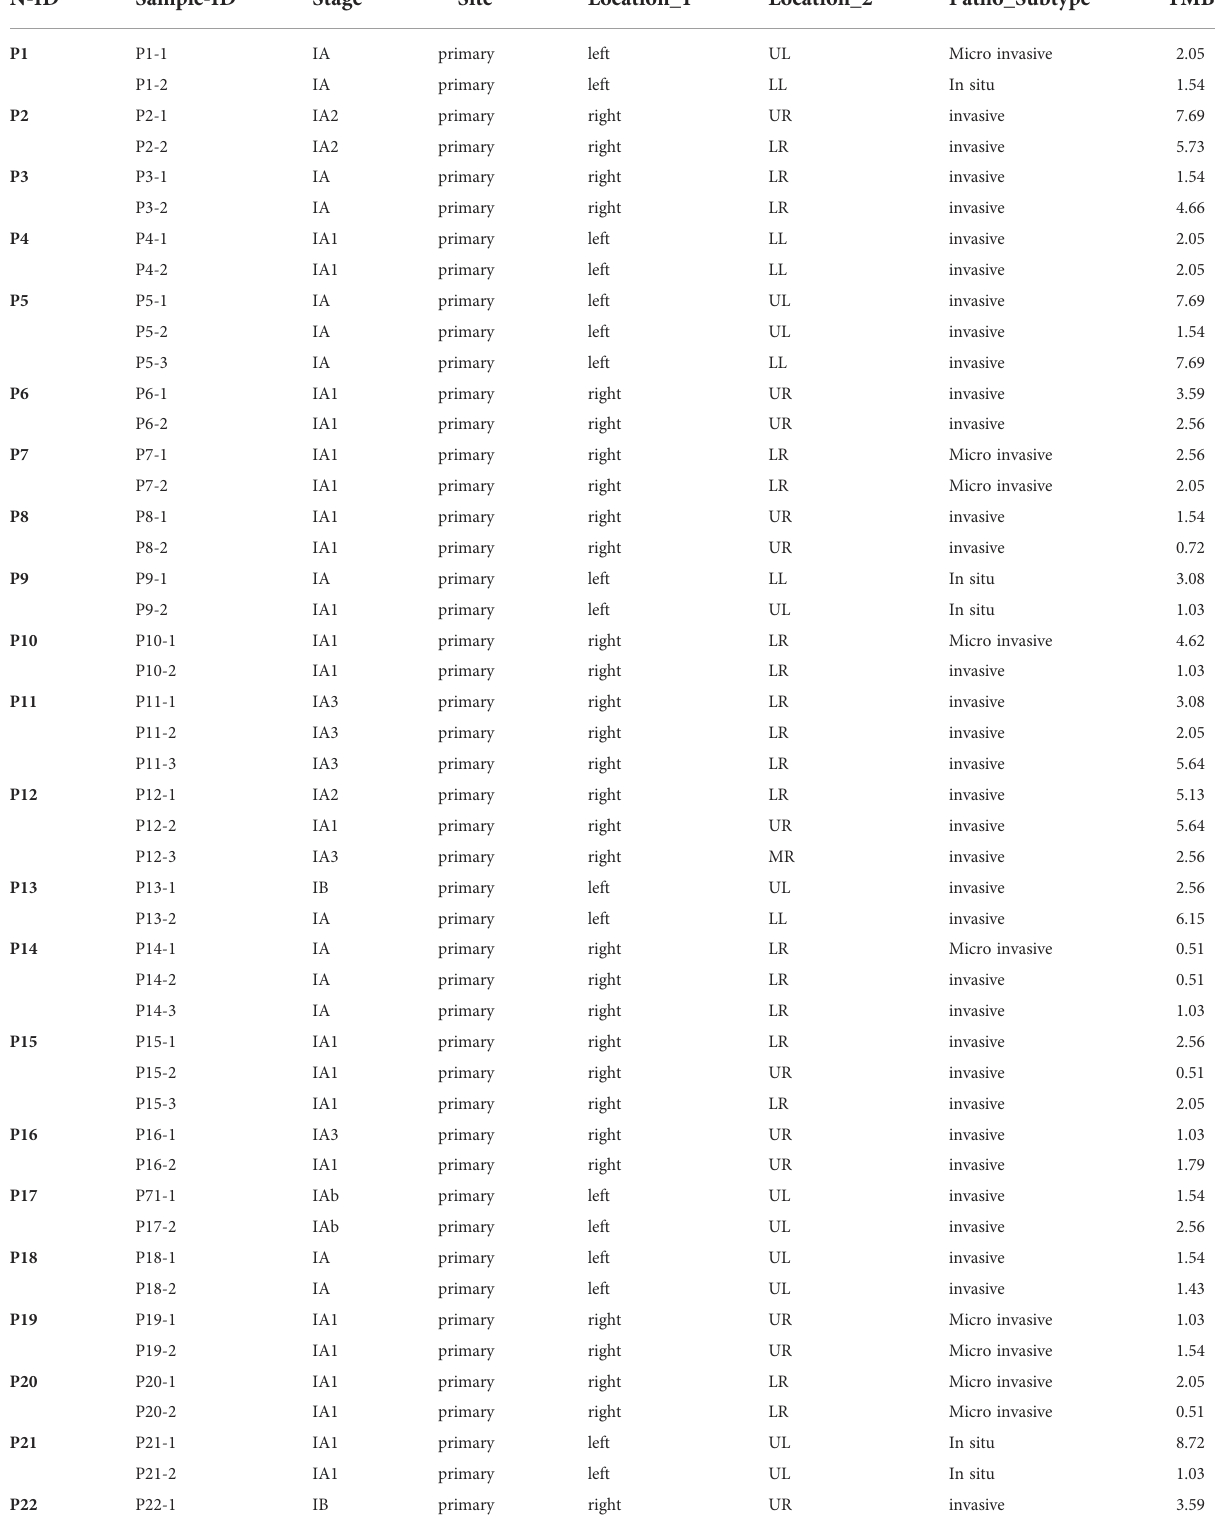
TABLE 3 The clinical and driver mutation genes characteristics of the two groups.